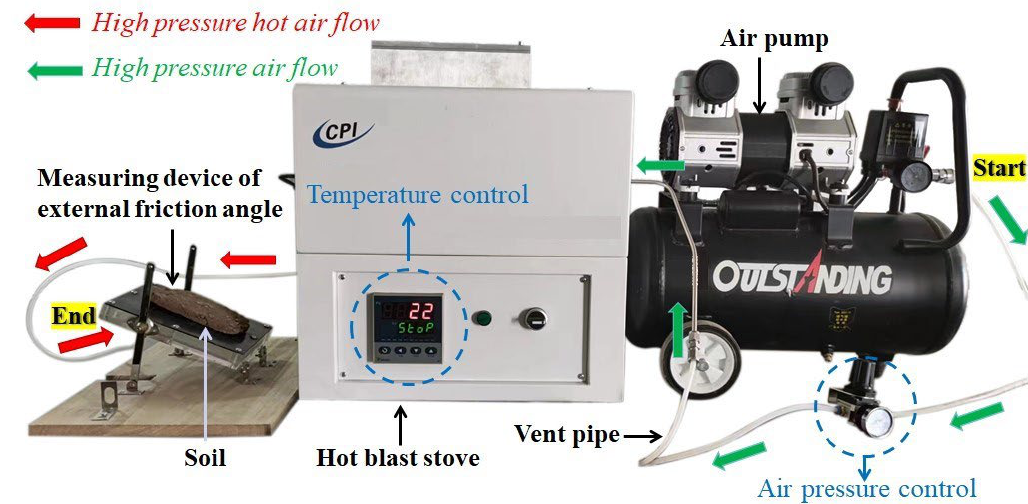
Figure 1. Experimental setup for measurement of external friction angle.